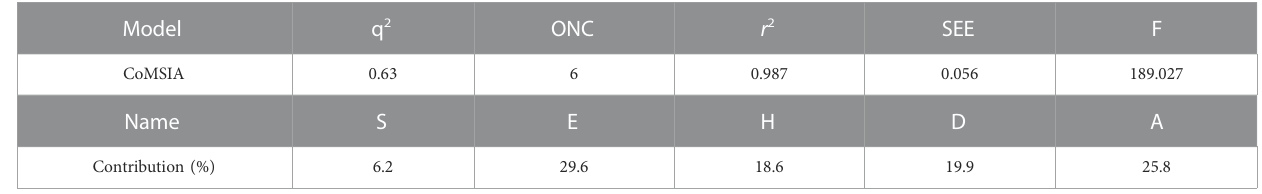
TABLE 5 Statistical results of the optimal CoMSIA model.